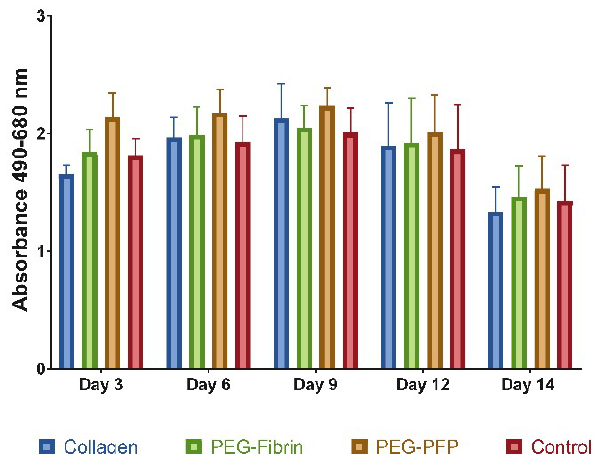
Figure 2. Re-epithelialization of 4 mm ex vivo explant. ( Top ) An explant treated with polyethylene glycol-platelet free plasma (PEG-PFP) hydrogel for 14 days was cryopreserved in a sucrose gradient, sectioned, and stained with wheat germ (WG, red) to visualize all plasma membrane surfaces and counterstained with 4′,6-diamidino-2-phenylindole ( DAPI) for nuclei (blue). The white dotted line represents the boundary between normal dermis (green auto-fluorescence) and the wound. ( Bottom ) Enlarged image shows the multilayer epidermis (6–8 cell layers thick) that formed over the PEG-PFP hydrogel.